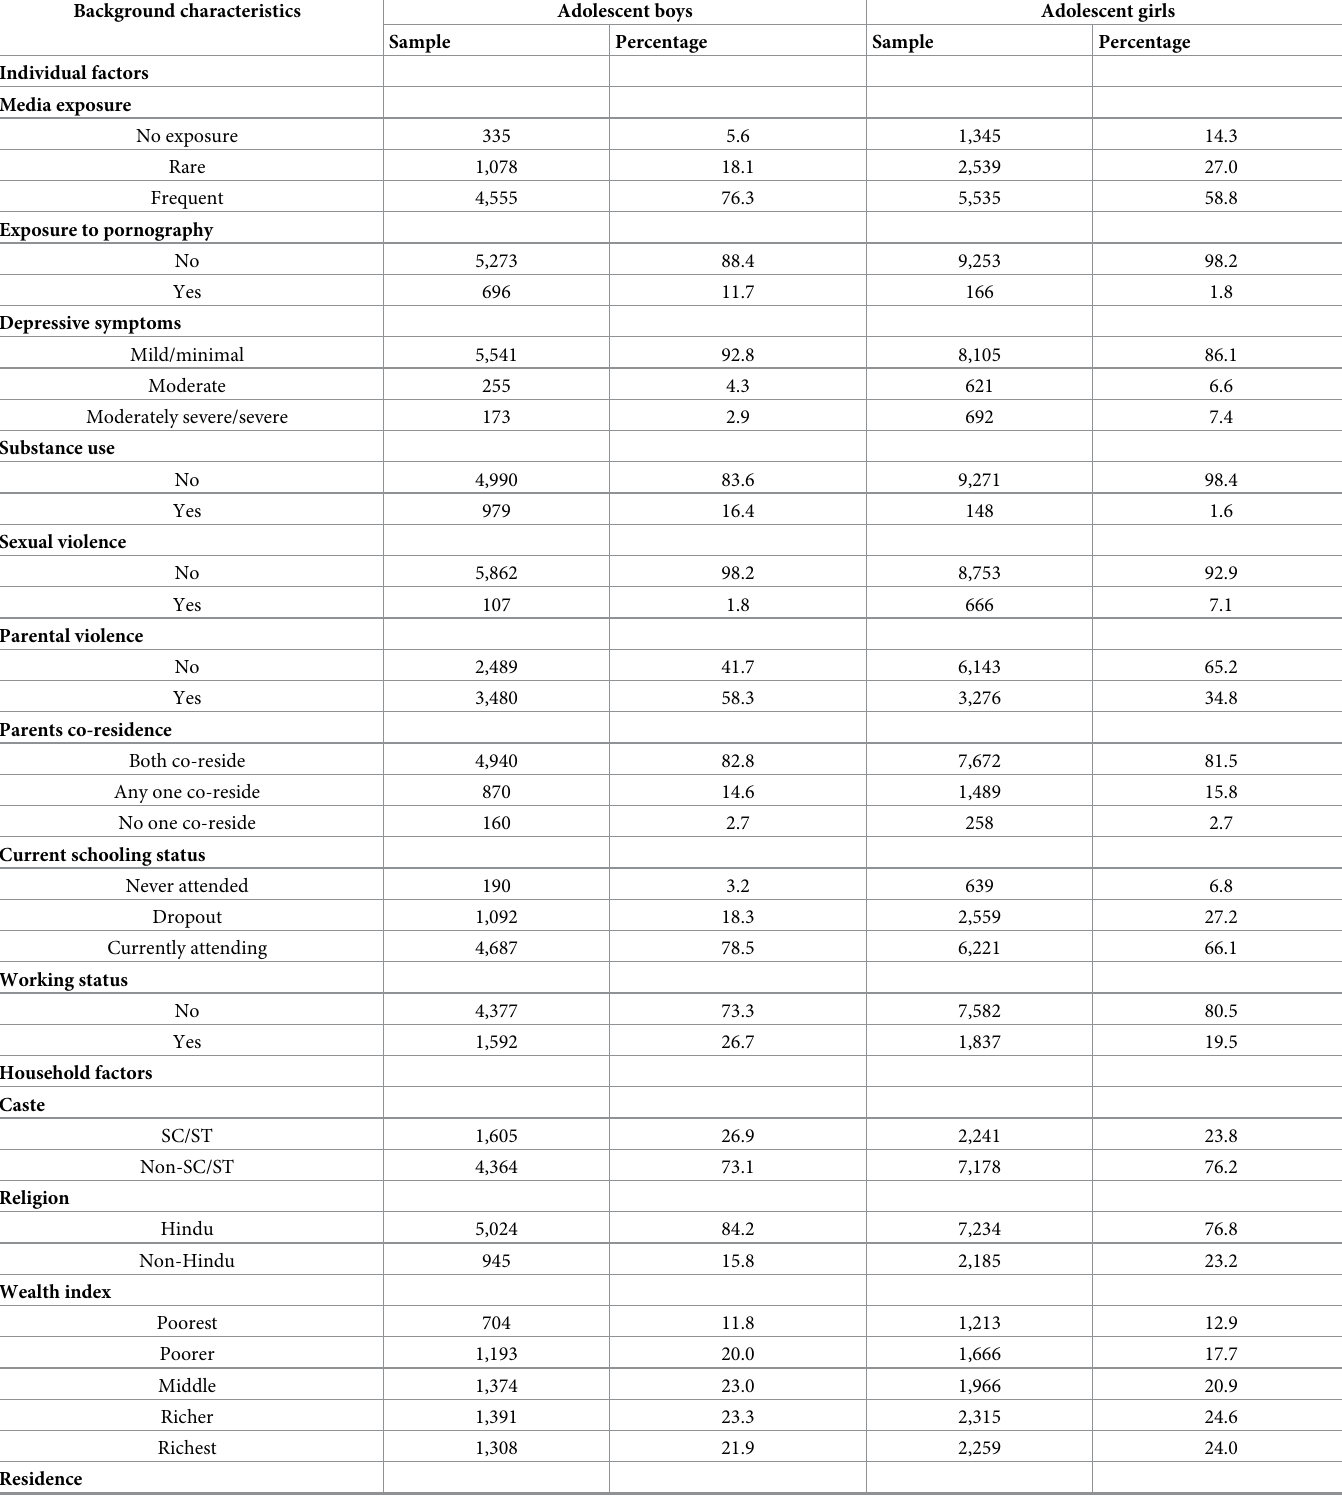
Table 1. Socio-demographic profile of adolescents boys and girls aged 10–19